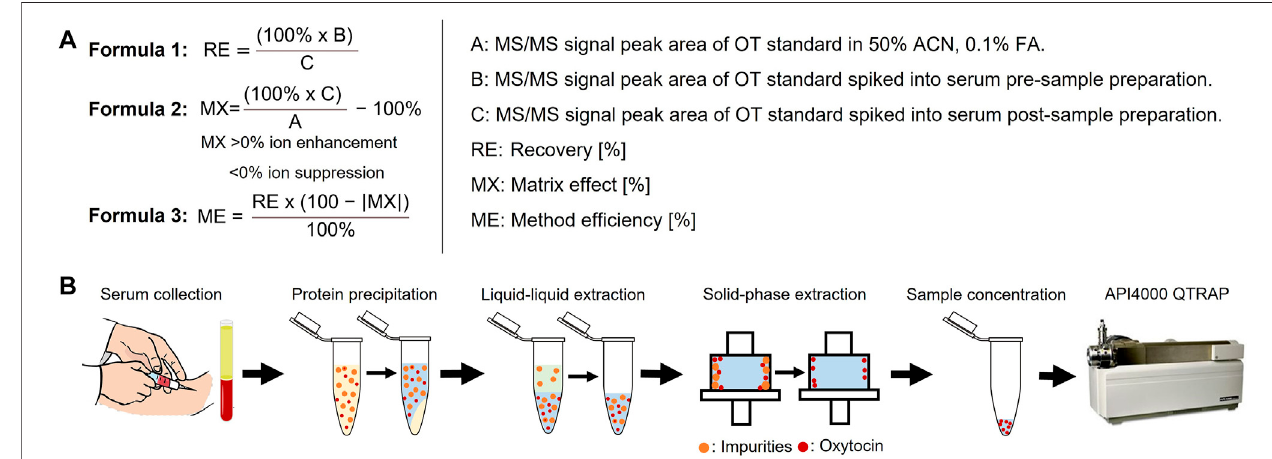
FIGURE2| Samplepreparation fl owchartandanalysis. (A) Calculationofpeptiderecovery(RE),matrixeffects(MX)andoverallmethodef fi ciency(ME).REprovides informationonthepeptiderecoveryofthesamplepreparationprotocol(fromproteinprecipitationtosampleconcentration).MXprovidesinformationonobservedmatrix effects, with positive values indicating ion enhancement and negativevalues indicating ion suppression effects. ME combines RE and MX values toprovide comparative information on the overall method ef fi ciency. RE values > 115% and MX values > ±100% were set to zero for the ME calculation to exclude methods based on false positives. MS/MS signal peak areas are taken as log 10 (counts). (B) Overview of the sample preparation steps that were optimized.